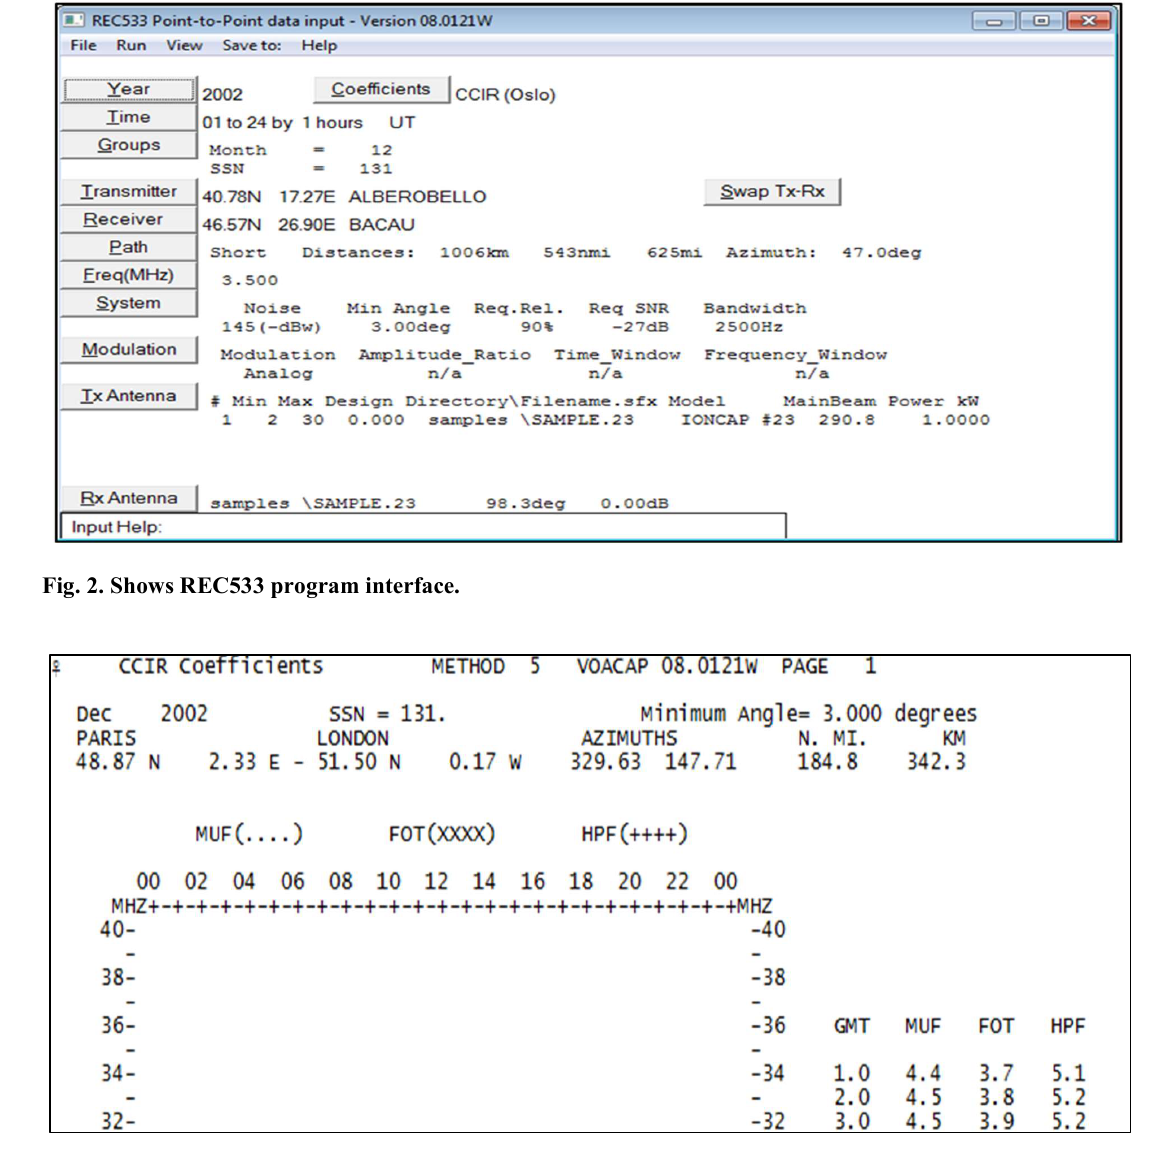
Fig. 3. Shows sample of VOACAP predicted result.